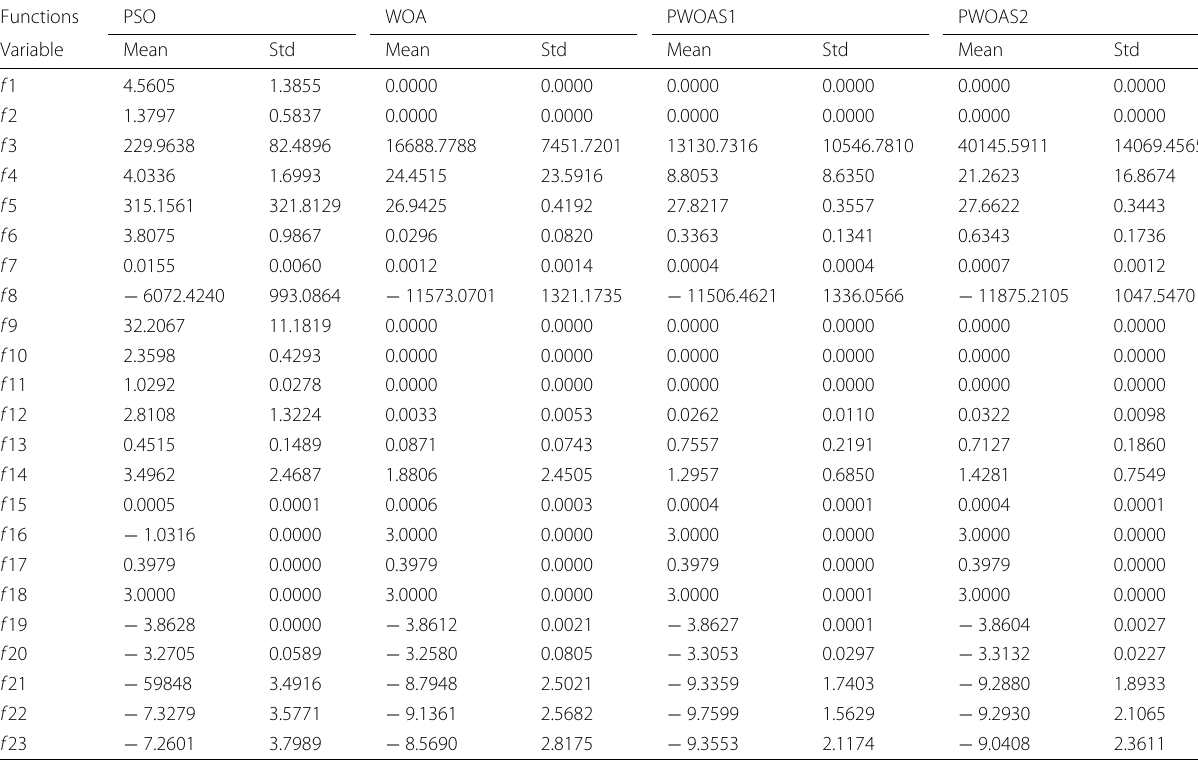
Table 2 The results of simulation experiment shows the experimental results of algorithms under 23 classical test functions Functions